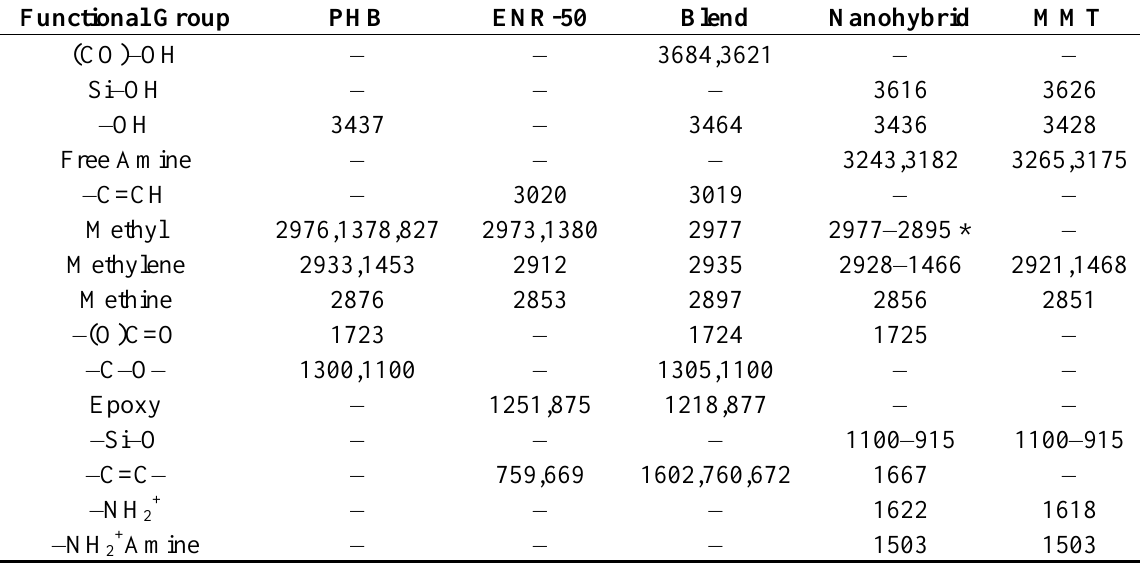
Table 1. FTIR adsorption bands of PHB, ENR-50, PHB/ENR-50 (50/50) blends, the respective nanohybrid containing 5 wt% MMT and